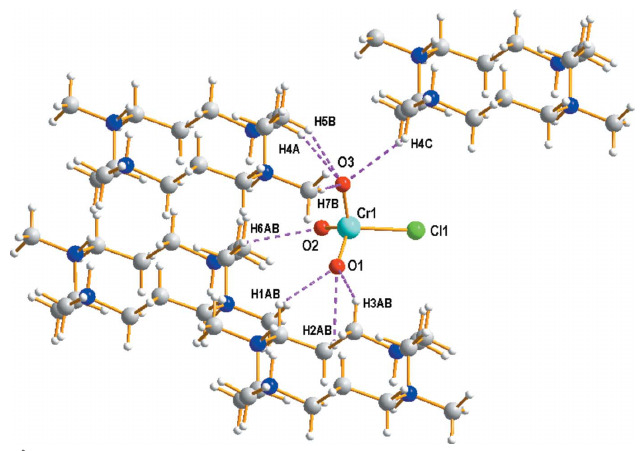
Figure 3 The C—H (cid:3)(cid:3)(cid:3) O hydrogen-bonding interactions between neighbouring organic cations and the CrO 3 Cl (cid:2) anion (see Table 1 for details).